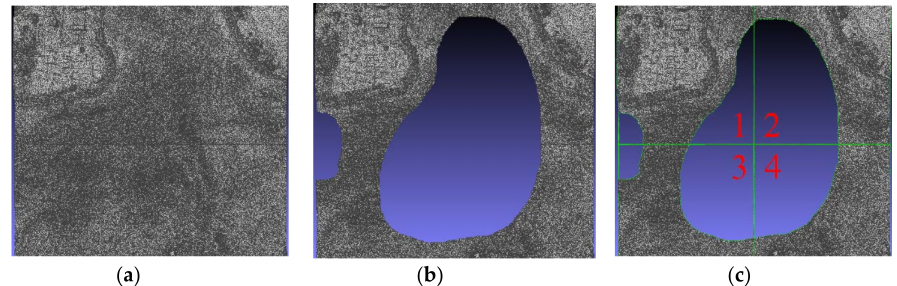
Figure 14. ( a ) Original triangular surface; ( b ) closed and unclosed holes created manually; ( c ) six open holes created by partitioning.